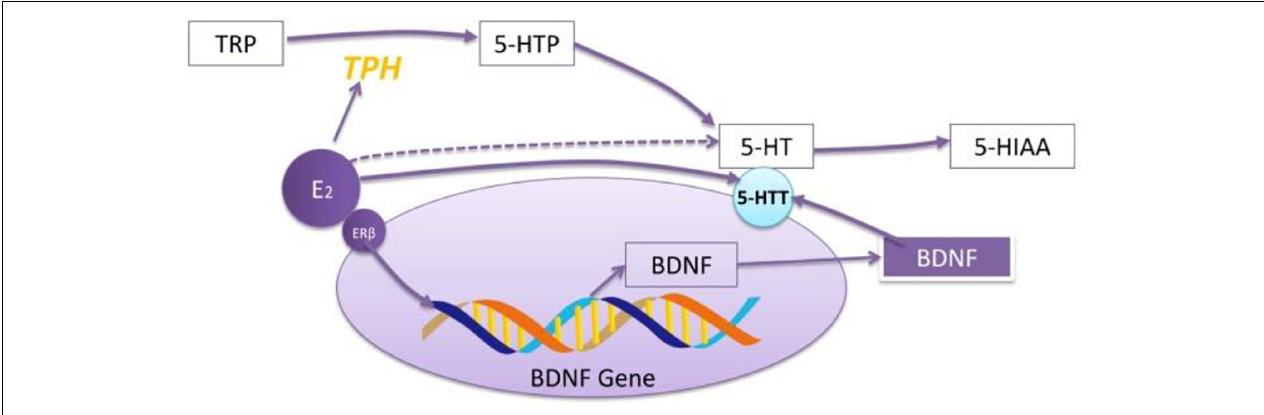
FIGURE 1 | The role of E2 in regulating the effect of 5-HT. E2 increases the mRNA expression of TPH through exciting ER β . ER β regulates 5-HT through BDNF–5-HT2a pathway. E2 increases the reactivity of 5-HT to SSRI drugs. The effect of E2 on 5-HT depends on whether the model is established or not and the administration